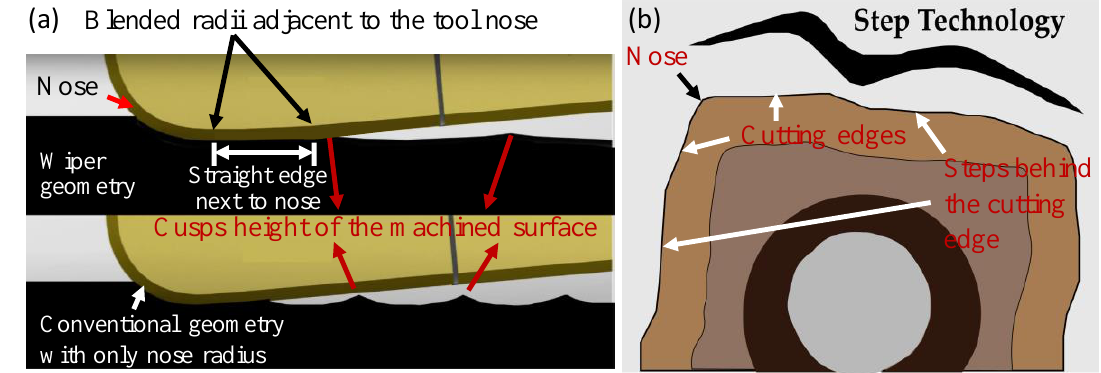
Table 1. Chemical Composition of Inconel 718 (standard vs. actual).